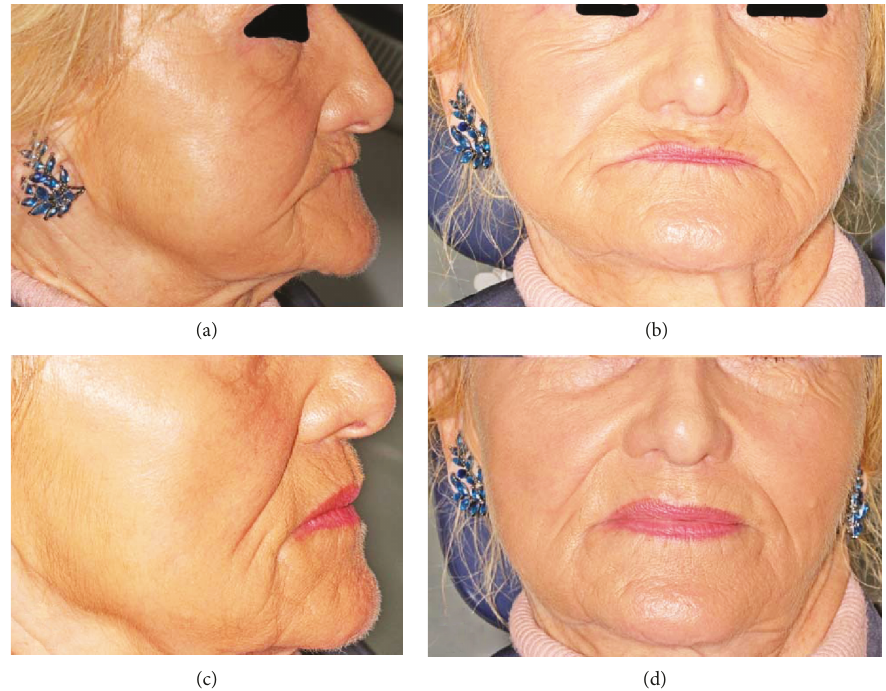
Figure 12: Final restoration delivered: (a) before treatment (lateral); (b) before treatment (frontal); (c) after treatment (lateral); (d) after treatment (frontal).